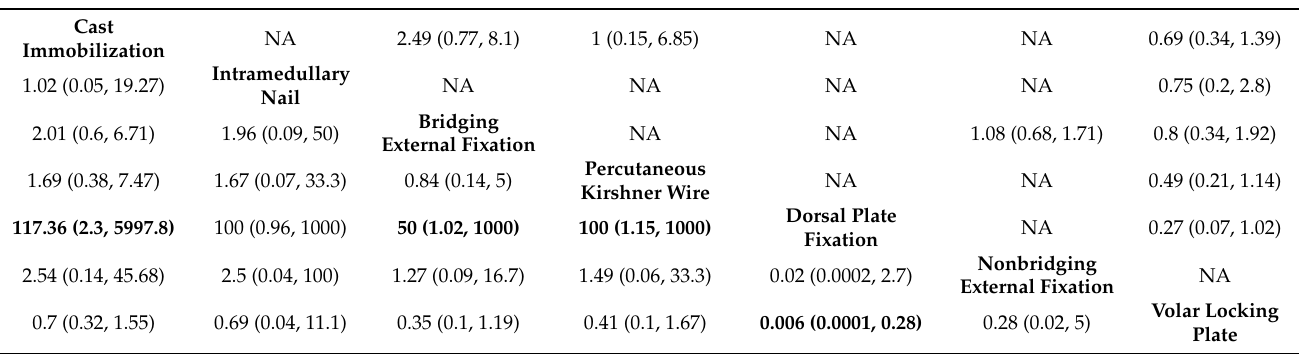
Table 7. Absolute and relative RR estimates (95% CI) on overall complications (*). Upper right triangle gives the mean difference from pairwise comparisons (column intervention relative to row) and lower left triangle gives the mean difference from the network meta-analysis (row intervention relative to